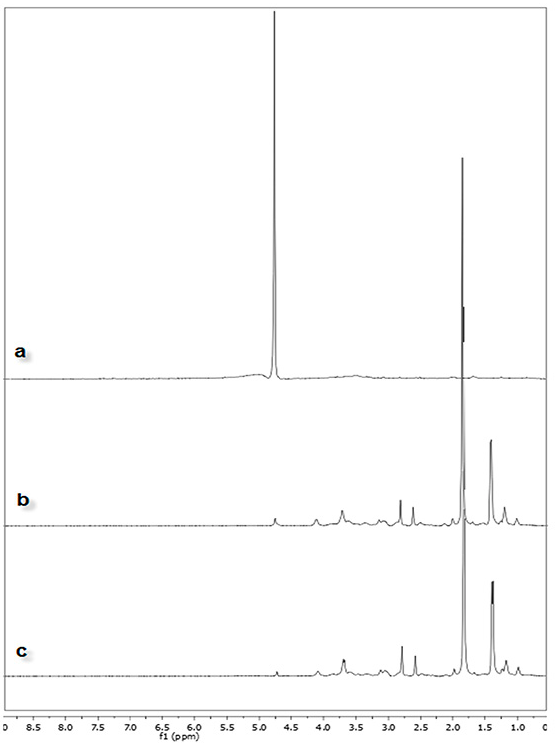
Figure 2. Proton nuclear magnetic resonance ( 1 HNMR) spectrum of in Deuterium Oxide (D 2 O) of ( a ) CS, ( b ) CSLA-NPs and ( c ) HACSLA-NPs.